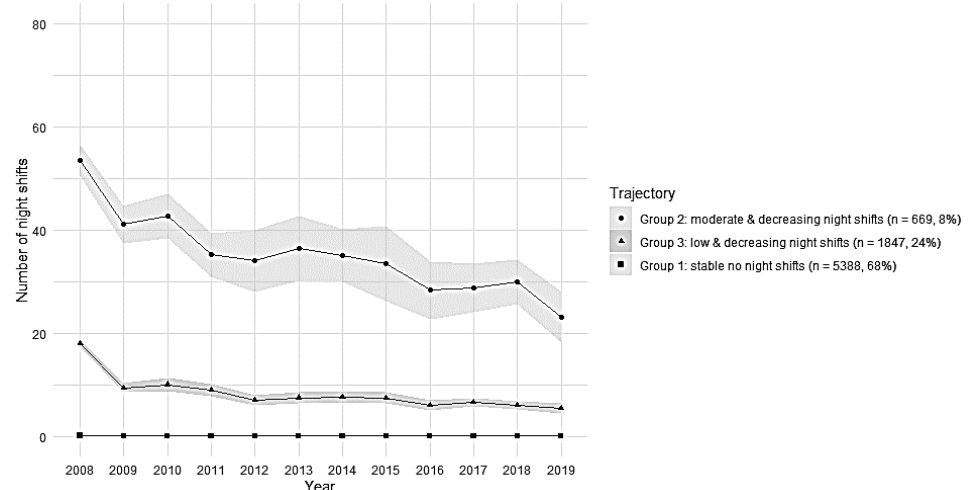
Figure 3. Trajectories of mean annual number of night shifts with 95% CI in sample 2 ( n = 7904 employees).